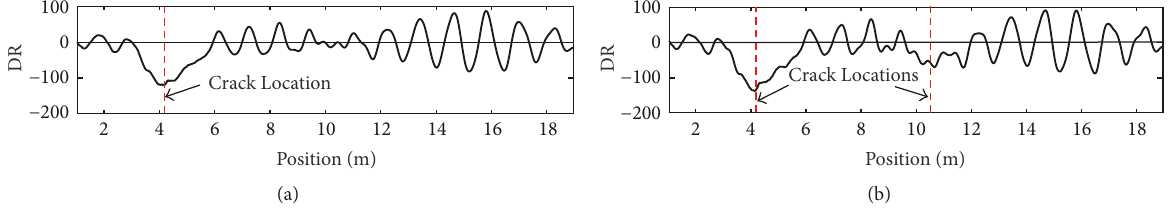
Figure 9: Damage ratio: (a) the first damage case and (b) the second damage case.